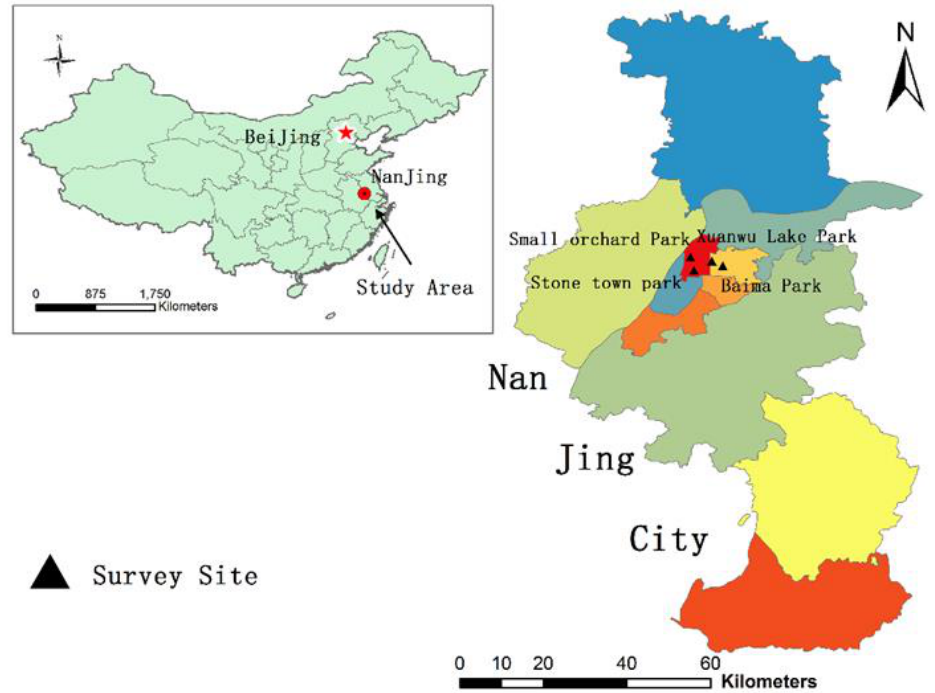
Figure 1. The site distribution of the questionnaire survey.